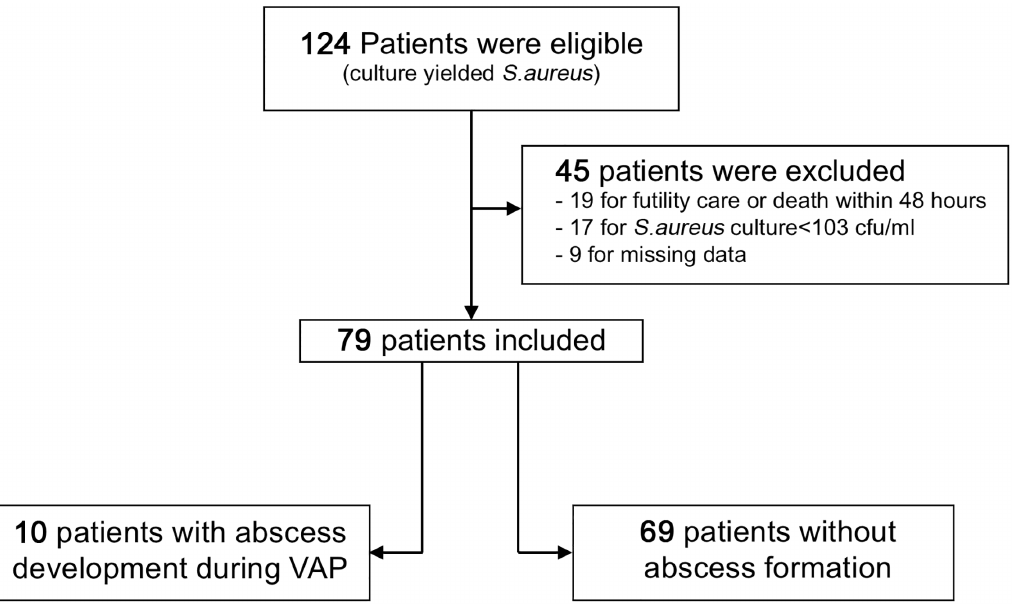
Fig 1. Flow chart of the study. Exclusioncriteria: (i): pneumoniasthat were not associatedwith mechanicalventilation; (ii) patients with preexisting (ICU admission)major lung insult (e.g.; important emphysema or antecedent of lung abscess), (iii) patients suffering from α 1-antitrypsin deficiencyor cystic fibrosis, (v) VAP without microbiological documentation, (vi) all situationswhen futility of care within the first 48h followingdiagnosis was anticipated, (vii) and death within the first 48h. Cfu, colony forming unit; VAP, ventilatorassociatedpneumonia.